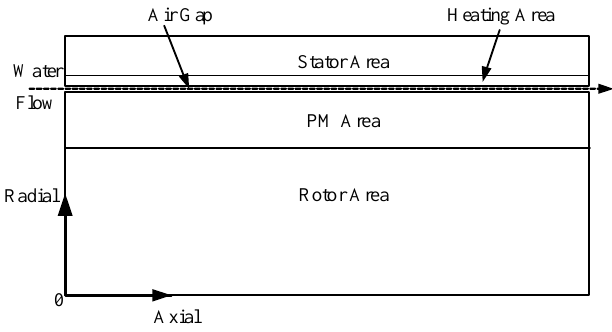
Figure 11. Calculation model of the temperature field.